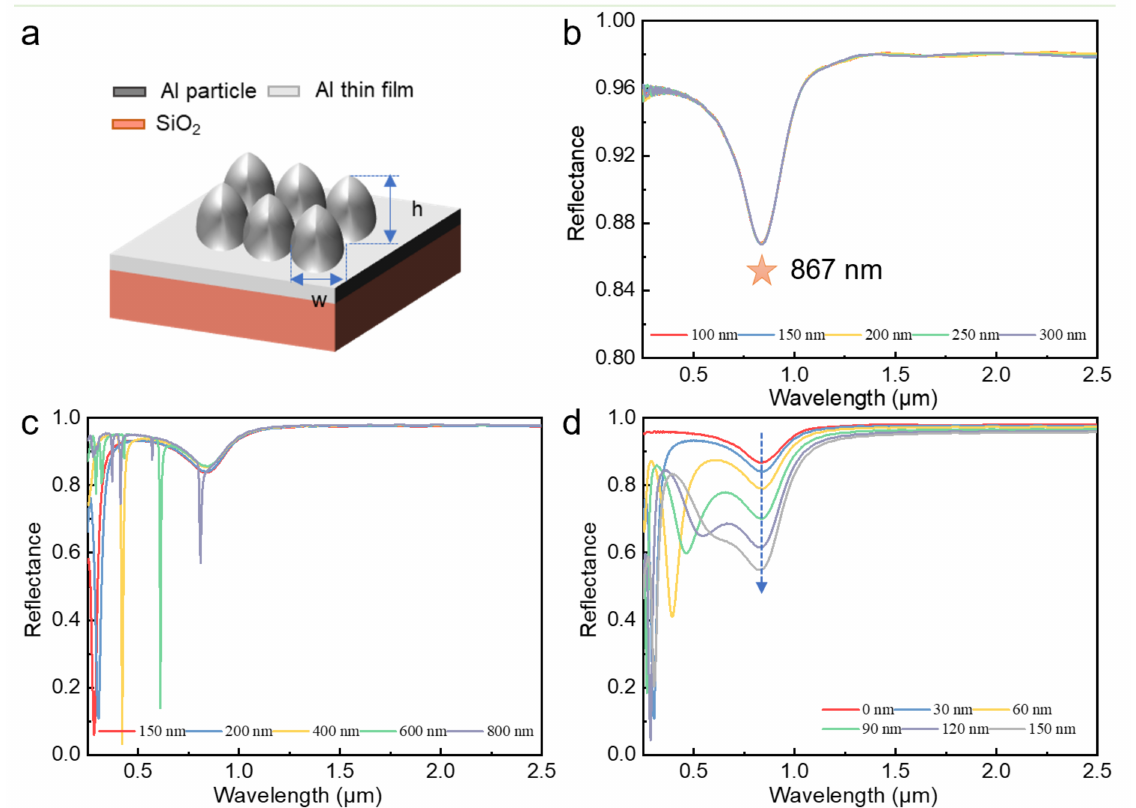
Figure 6. ( a ) Schematic representation of the Al films with nano-particles on the surface. ( b ) The simulated reflectance spectra of the planar Al films with no nano-particles. The simulated reflectance spectra of the Al films with the nano-particles: ( c ) particle height is 30 nm, width is from 150 nm to 800 nm, ( d ) particle height is from 30 nm to 150 nm, width is 200